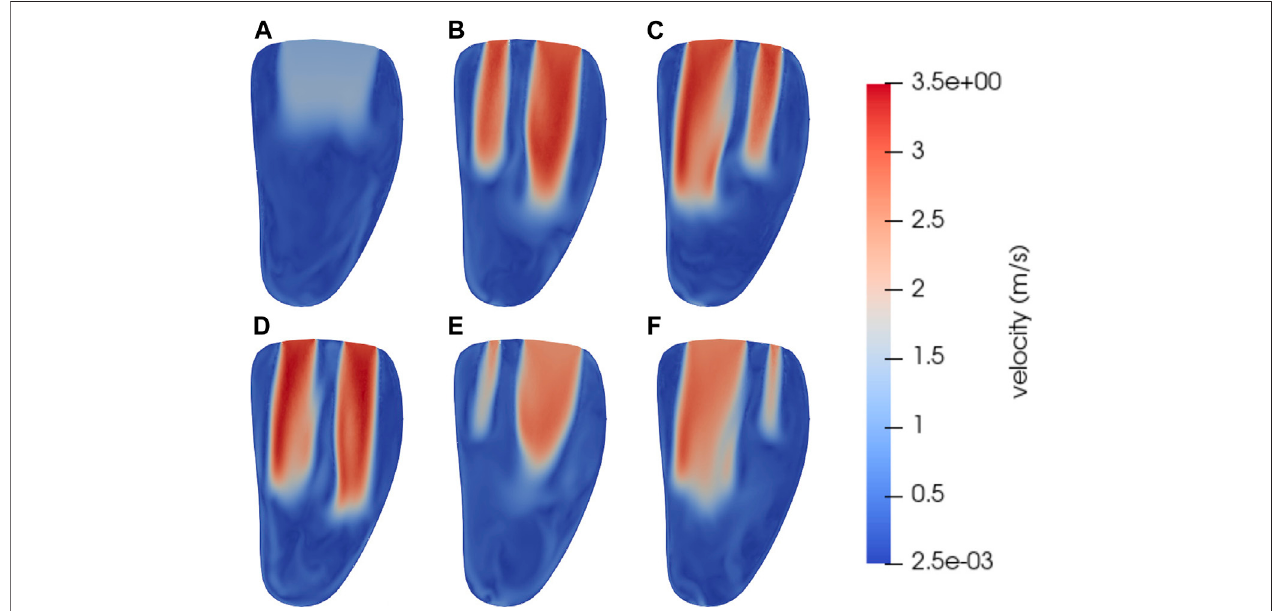
FIGURE3| Snapshotsofthevelocitymagnitudeattime t =0.45 sinaverticalbicommissuralcutthroughtheleftventricle.ThisisinearlydiastolebeforetheE-wave peak, when theintraventricularblood fl owisdominatedbystrong in fl owjets. Sub fi gure (A) showsthe untreated case. The other sub fi gures haveMVC ’ spositionedat s · l from the center, with l being thelong axis ofthe MVmodel. The scalefactor s forthe differentcases are (B) s = − 0.2, (C) s = 0.2, (D) s =0.0, (E) s = − 0.4, (F) s =0.4. The corresponding MV areas for each case in mid diastole are given in Table 2 .